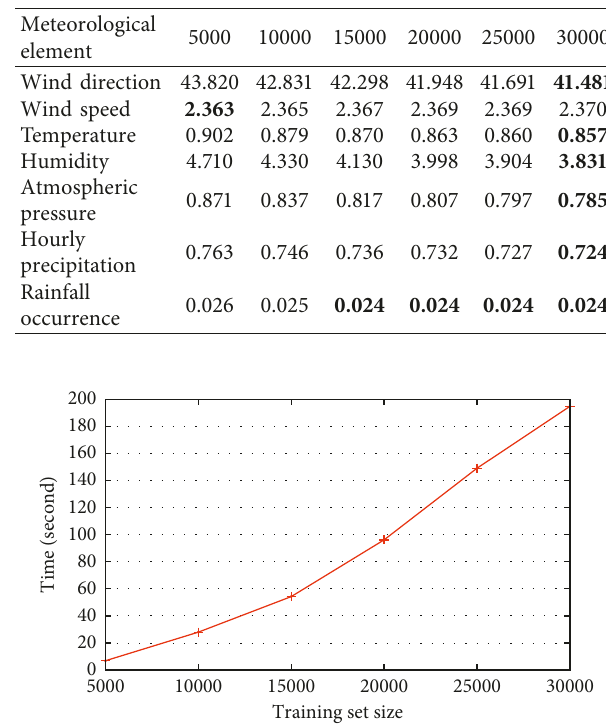
Table 8: Optimal number of neighboring stations per meteoro- logical element.